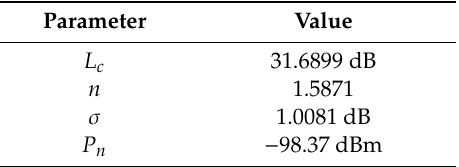
Table 2. Relevant parameters of Equation